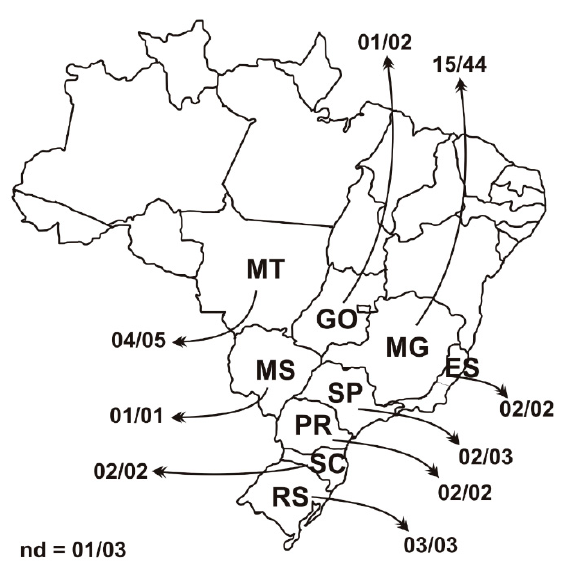
Figure 1. Distribution of the 67 tissue samples collected from pigs between 2006 and 2007 from nine states in Brazil. The number before the bar indicates the total of positive samples and the number after the bar indicates the sampling in each state. Nd = no data about sample origin; MT = Mato Grosso; MS = Mato Grosso do Sul; GO = Goiás; MG = Minas Gerais, SP = São Paulo; ES = Espírito Santo; SC = Santa Catarina; RS = Rio Grande do Sul; PR = Paraná.